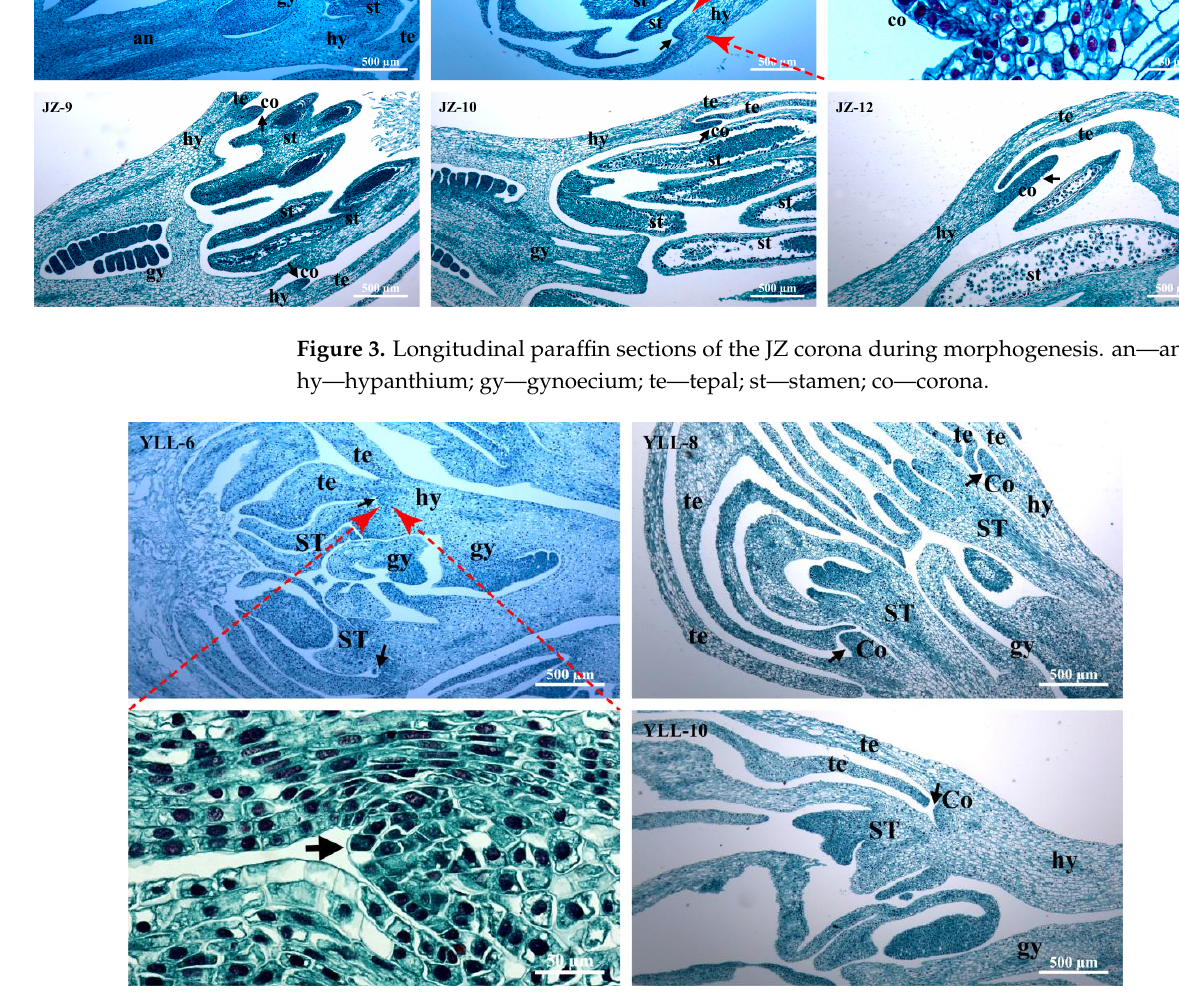
Figure 4. Longitudinal paraffin section of the YLL fragmented corona during morphogenesis. hy—hypanthium; gy—gynoecium; te—tepal; ST—petal-like stamen; Co—fragmented